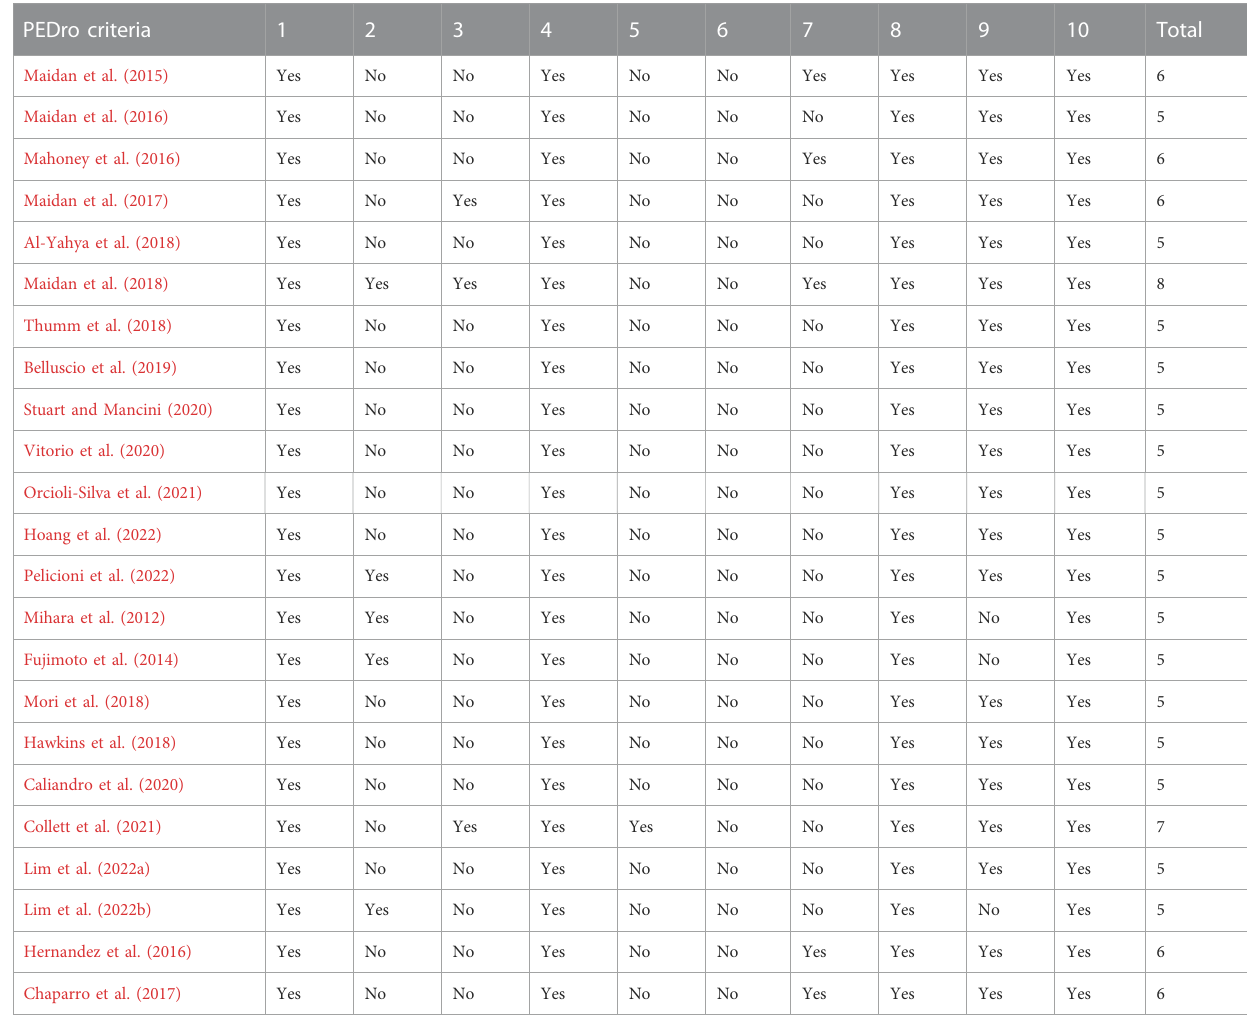
TABLE 4 Hysiotherapy evidence database (PEDro) Scale scores of the reviewed studies. PEDro